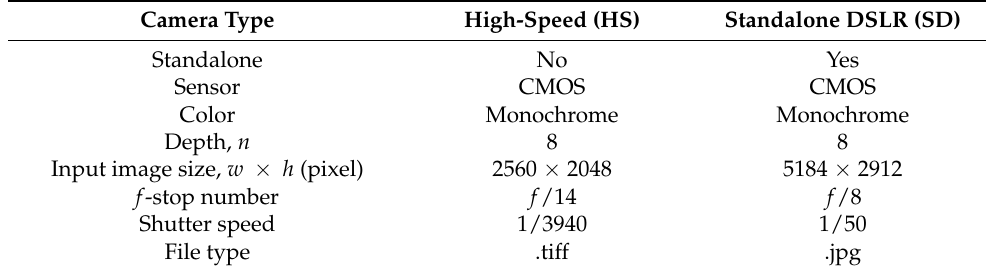
Table 1. Vision ‐ based system configuration sets for one ‐ inch block validation experiment. Table 1. Vision-based system configuration sets for one-inch block validation